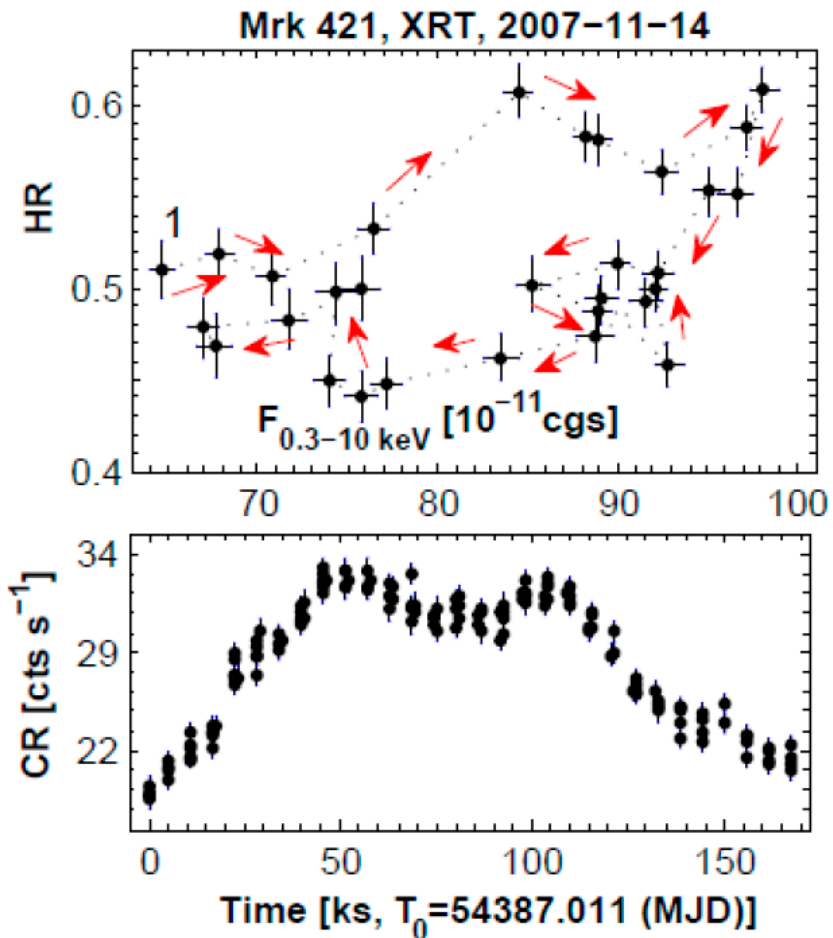
Figure 7. HR-flux plane ( upper panel ) from the densely-sampled, prolonged Swift-XRT observation of the intra-day 0.3–10 keV flare ( lower panel ) in Mrk 421 performed on 14 November 2007. This flare was characterized by the features of efficient stochastic acceleration—low spectral curvature and the E p - b anti-correlation (reproduced from Reference [24]).